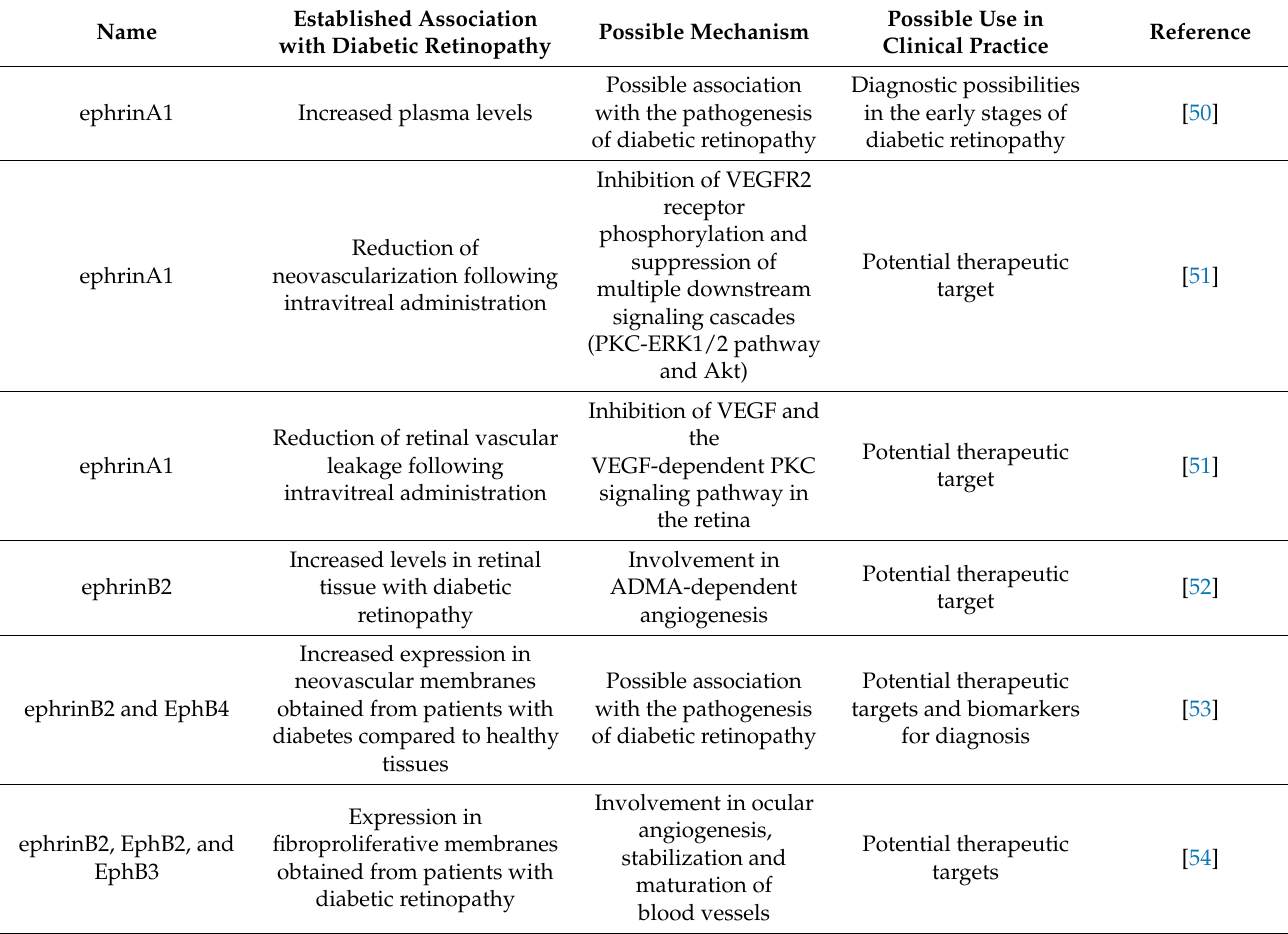
Table 1. A summary of the identified associations of Eph and ephrins with diabetic